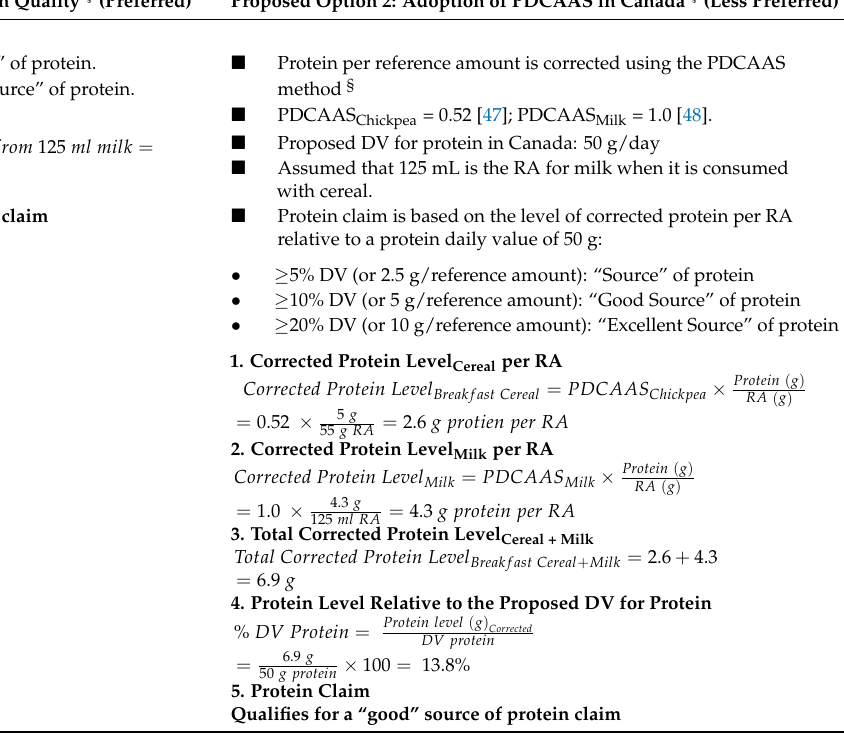
Corrected Protein Level Breakfast Cereal = PDCAAS Chickpea × Protein ( g ) RA ( g ) 2. Corrected Protein Level Milk per RA Corrected Protein Level Milk = PDCAAS Milk × Protein ( g ) RA ( g ) = 1.0 × 4.3 g = 4.3 g protein per RA 125 ml RA 3. Total Corrected Protein Level Cereal+Milk Total Corrected Protein Level Breakfast Cereal + Milk = 2.6 + 4.3 = 6.9 g 4. Protein Level Relative to the Proposed DV for Protein % DV Protein = Protein level ( g ) Corrected DV protein = 6.9 g × 100 = 13.8% 50 g protein 5. Protein Claim Qualifies for a “good” source of protein